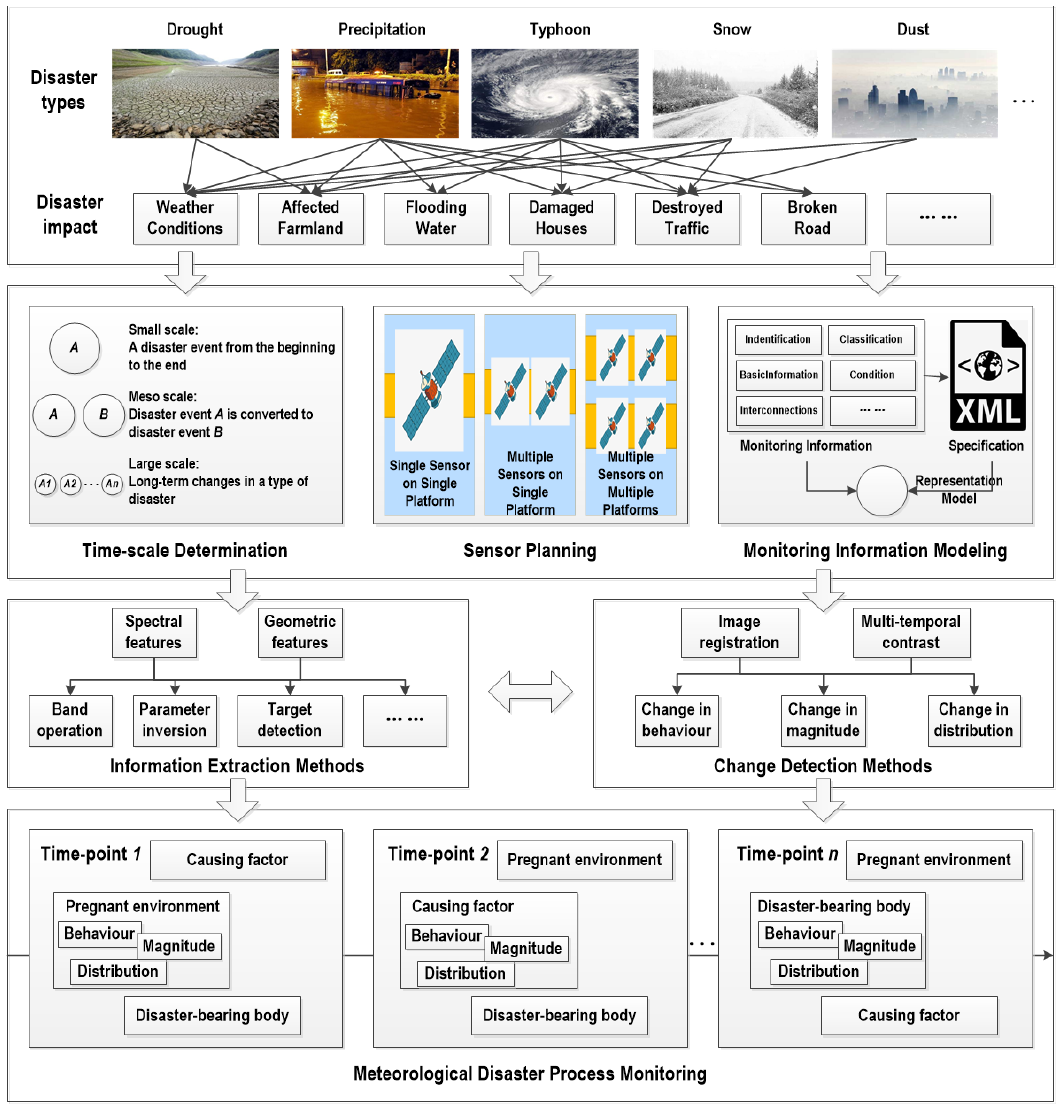
Figure 1. Technical roadmap of meteorological disaster monitoring based on remote sensing.